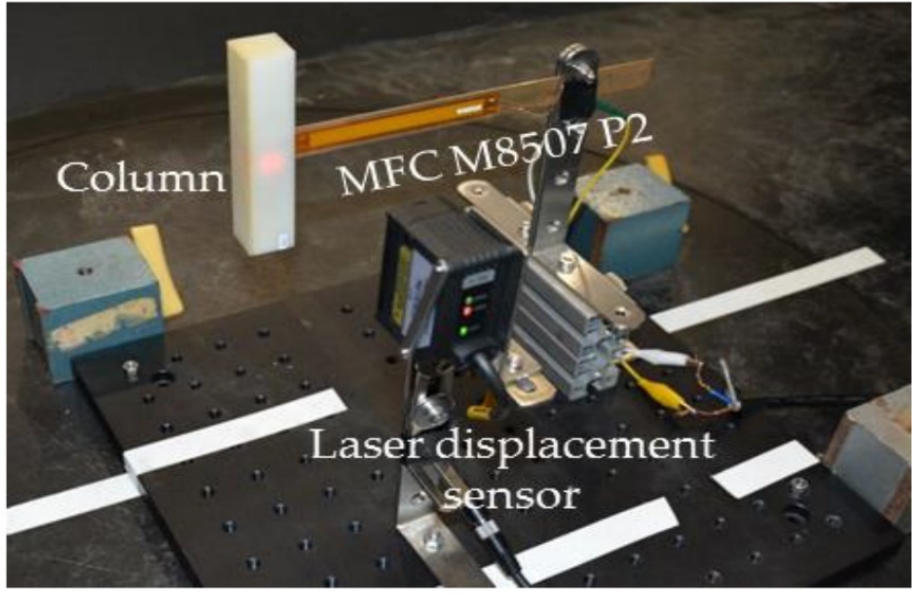
Figure 6. Galloping piezoelectric energy harvester with V-shaped groove in low wind speed, adopted from [66].